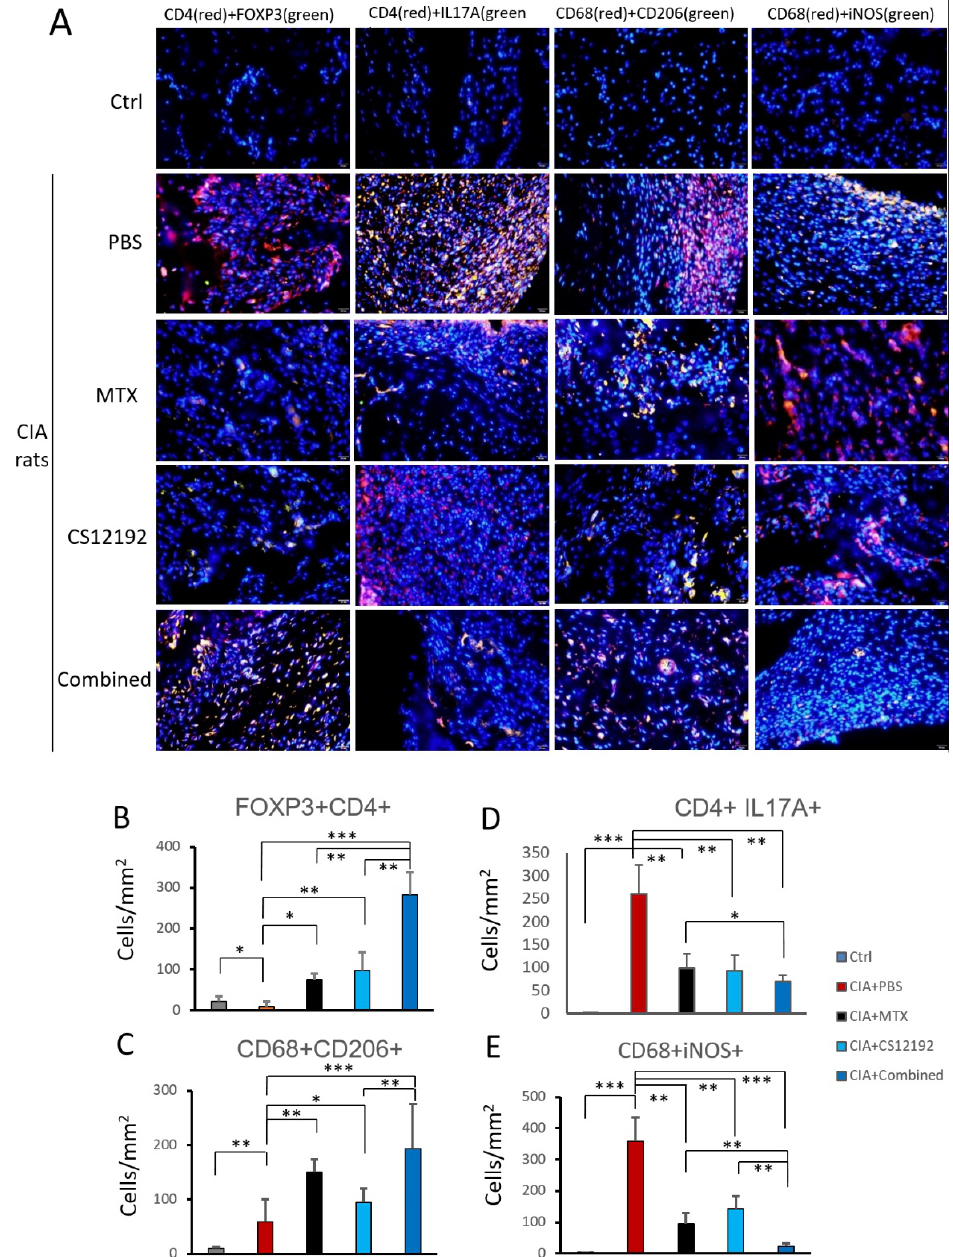
Figure 4. Effects of MTX, CS12192, or the combination of CS12192 and MTX treatments on T cell and macrophage infiltration and activation in CIA rats on day 28 by two-color immunofluorescence, ( A ) Representative two-color immunofluorescence for Treg cells (CD4+ FOXP3+), Th17 cells (CD4+ IL-17A+), M2 macrophages (CD68+ CD206+), and M1 macrophages (CD68+ iNOS+) infiltrating joint tissues on day 28 after the first immunization of CIA rats receiving different treatments. Nuclei were stained with DAPI (blue); ( B – E ) Quantitative analysis of T cell and macrophage subsets infiltrating the joint tissues. Each bar represents the mean ± SEM for 10 CIA rats in different groups. Scale bar = 50 µ m. * p < 0.05; ** p < 0.01; and *** p < 0.001 vs. CIA